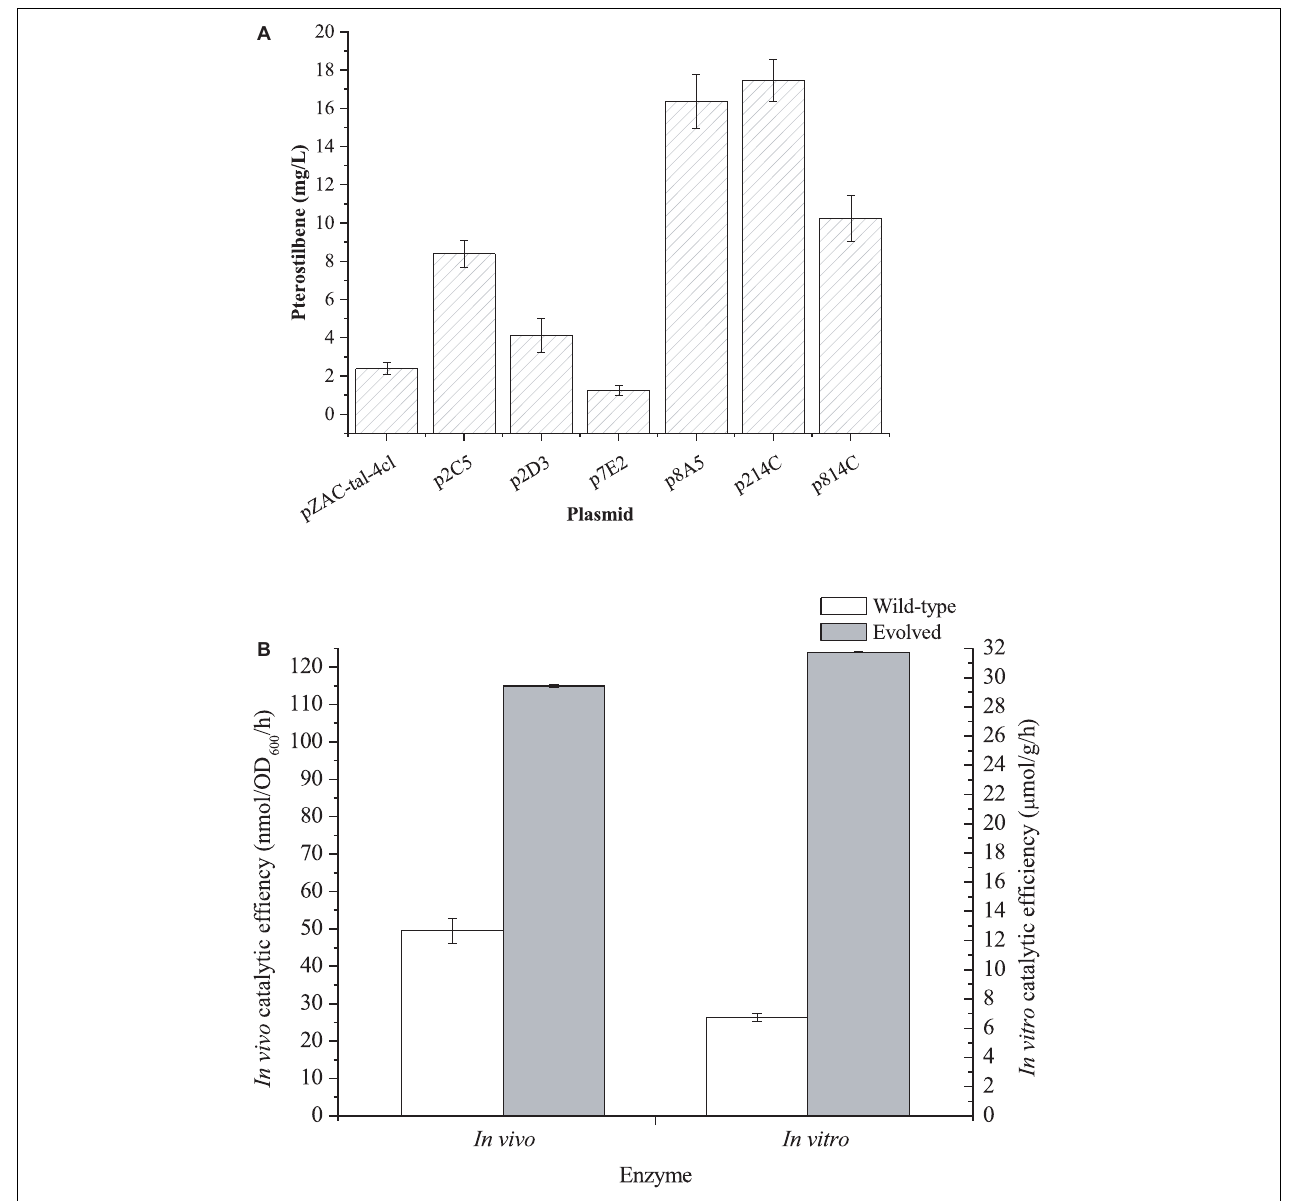
FIGURE 2 | (A) De novo pterostilbene production by E. coli TYR-30 harboring the mutant plasmids of pZAC-tal-4cl and pZBK-sts-romt. (B) In vivo and In vitro catalytic efficiency of the evolved pathway enzymes of TAL-4CL and its wild-type enzymes. In vivo activity was defined as the L-tyrosine consuming rate of the whole resting cells and In vitro activity was defined as the L-tyrosine consuming rate of the crude extract. The data represent means of three replicates and error bars represent standard deviations.